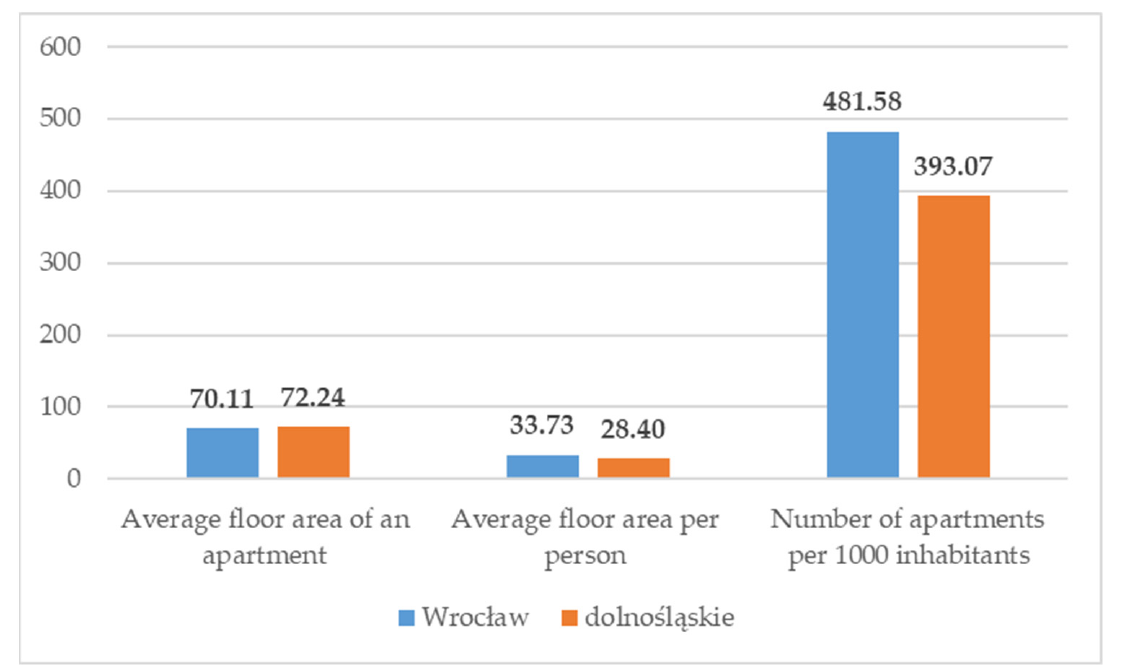
Figure 16. Indicators of housing infrastructure availability in Wrocław and the Lower Silesian Province.